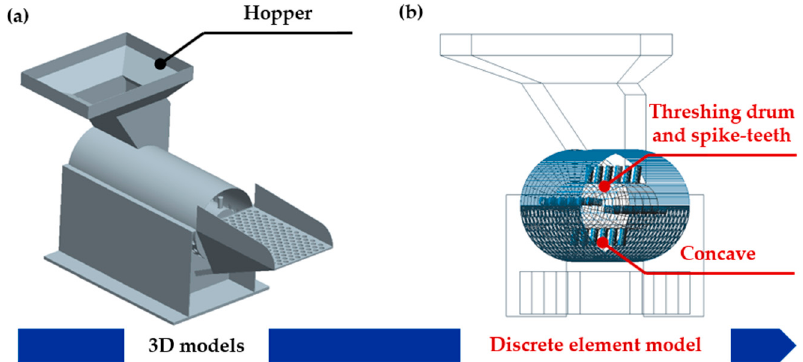
Figure 2. CAD model and DEM numerical model of a drum-type corn-thresher: ( a ) CAD model and